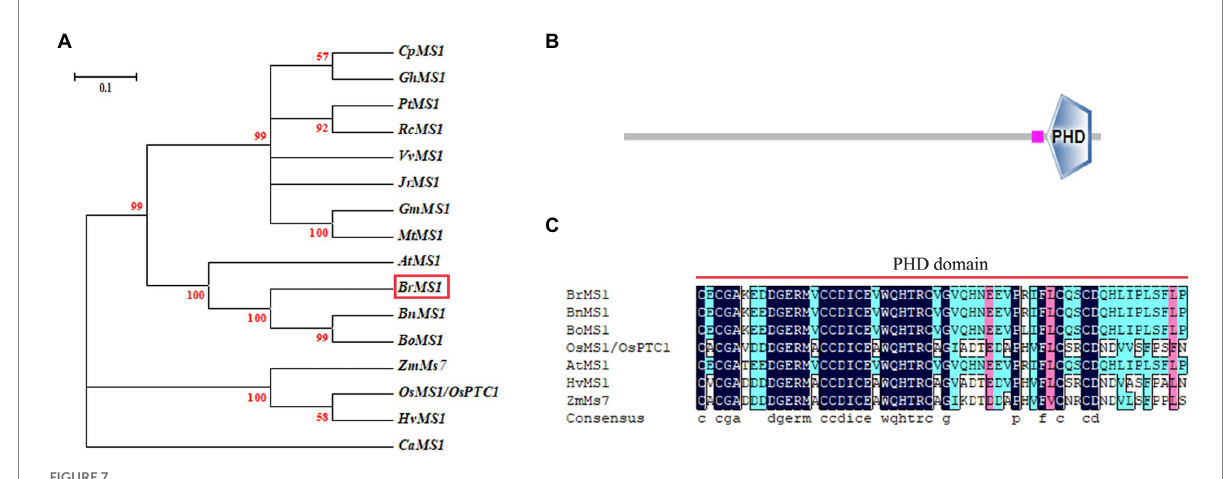
FIGURE 7 PHD-finger domain sequence alignment in different species and phylogenetic analysis of MS1 . (A) Phylogenetic analysis of MS1 and its related proteins. An unrooted maximum likelihood tree was created by MEGA 3.1 using the MS1-related sequences from Carica papaya ( Cp ), Gossypium hirsutum ( Gh ), Populus trichocarpa ( Pt ), Ricinus communis ( Rc ), Vitis vinifera ( Vv ), Juglans regia ( Jr ), Glycine max ( Gm ), Medicago truncatula ( Mt ), Arabidopsis ( At ), Brassica rapa ( Br ), Brassica napu ( Bn ), Brassica oleracea ( Bo ), Zea mays ( Zm ), rice ( Os ), barley (Hv), Capsicum annuum ( Ca ). (B) Conserved domain structure of BrMS1. (C) PHD-finger domain sequence alignment. Residues with 100% similarity are shaded in black. Those with ≥ 75% similarity are shaded in pink. Those with ≥ 50% similarity are shaded in blue.